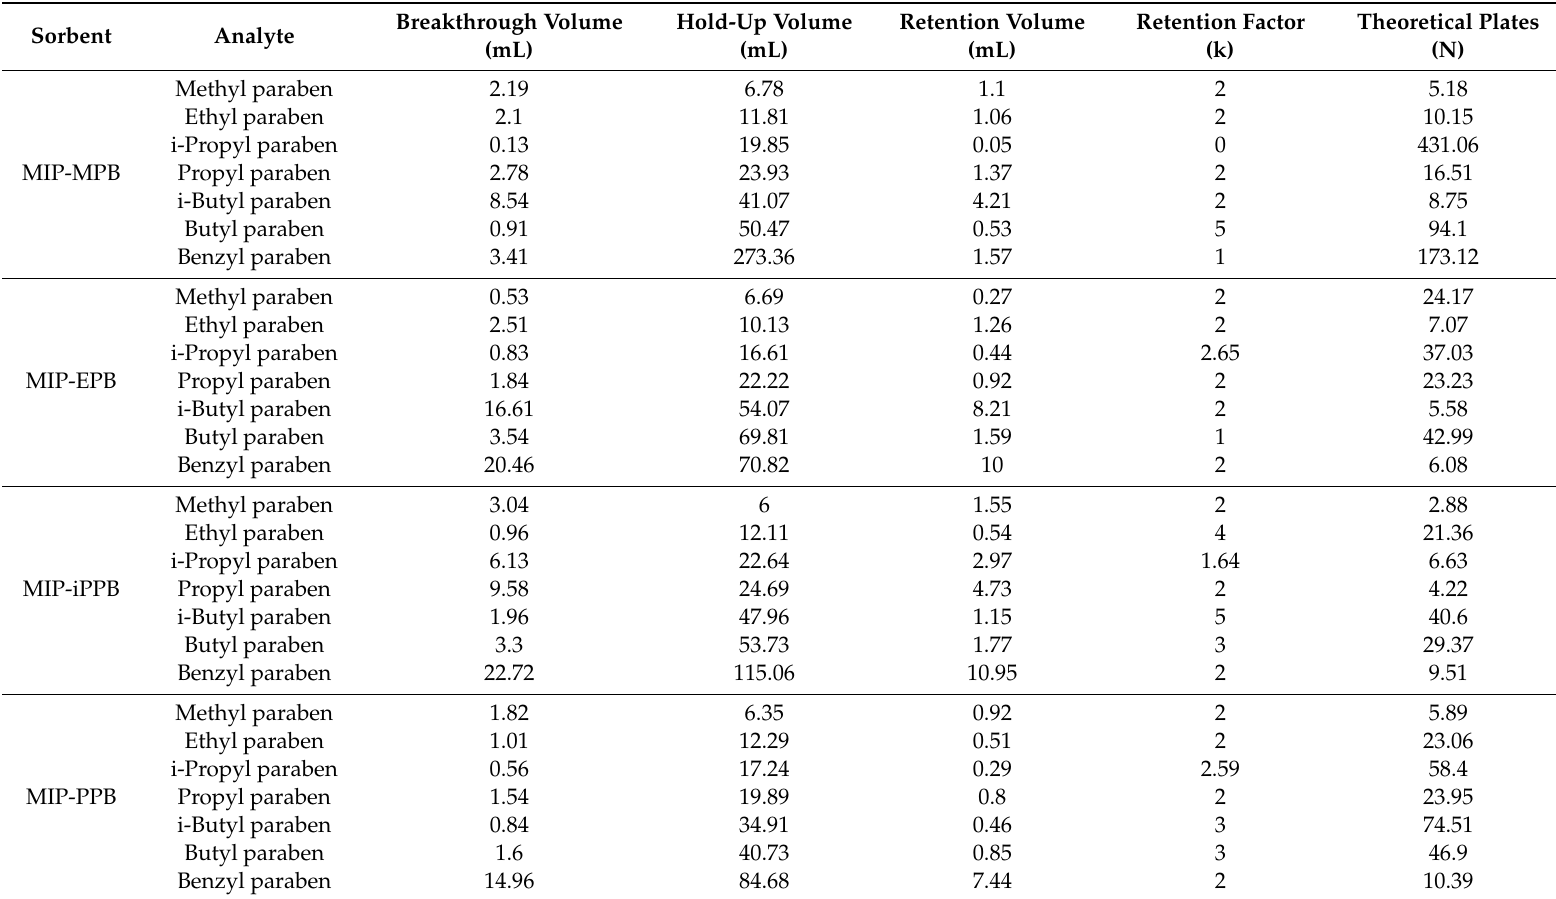
Table 2. Parameters determined for the analytes on di ff erent MIP sorbent at the concentration of 50 µ g /